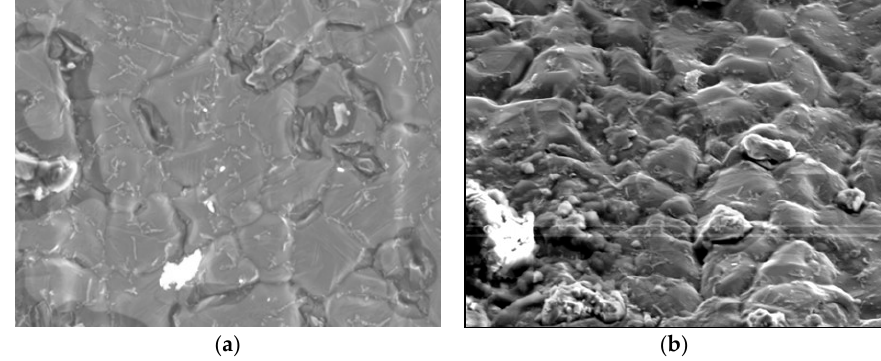
Figure 5. ( a ) Top-down and ( b ) tilted SEM images of SS 316L sample surface after 100 h heating (5000×).